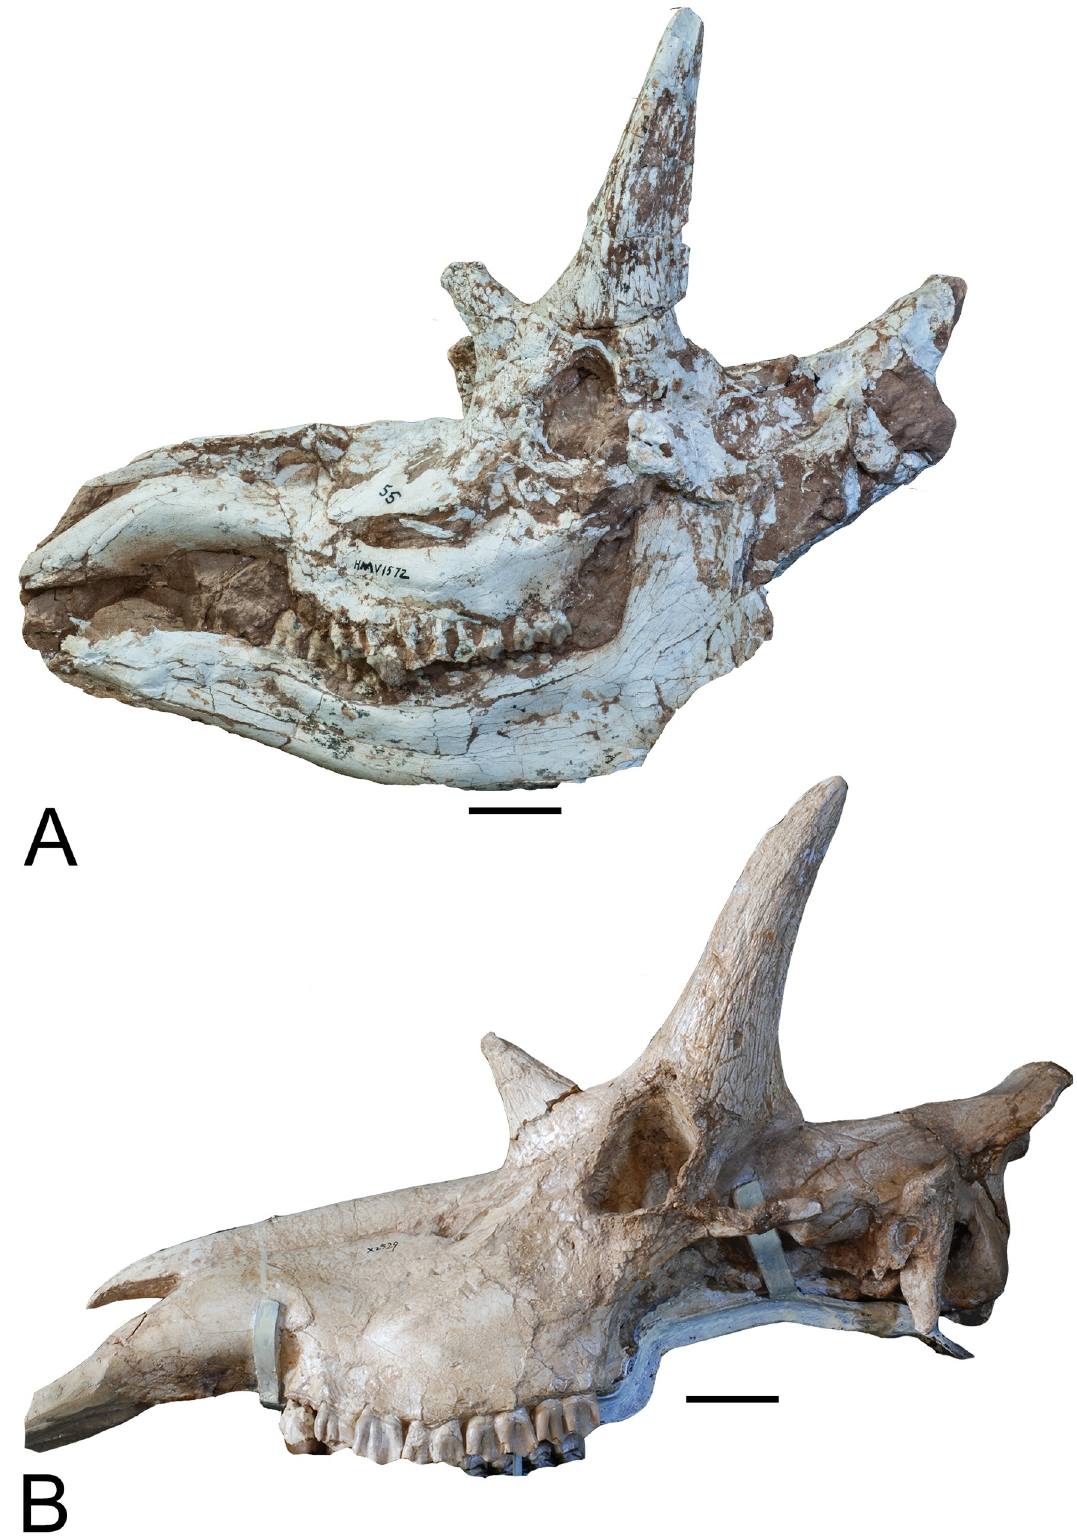
Fig 3. Schansitherium tafeli skulls. (A) HMV 1943 left lateral aspect. (B) HMN 1934 left lateral view. Scales 50mm.